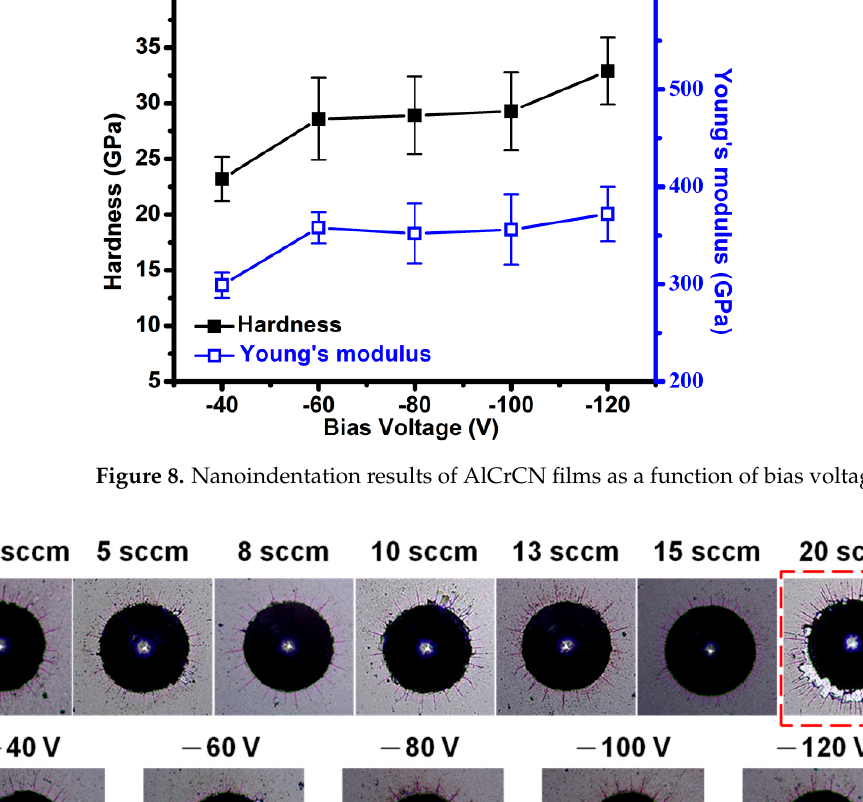
Figure 7. BF, SAED ( a lower right and b lower left) and DF TEM ( a top left and b top right) images of AlCrCN fi lm as a function of bias voltage ( − 40 V and − 100 V).